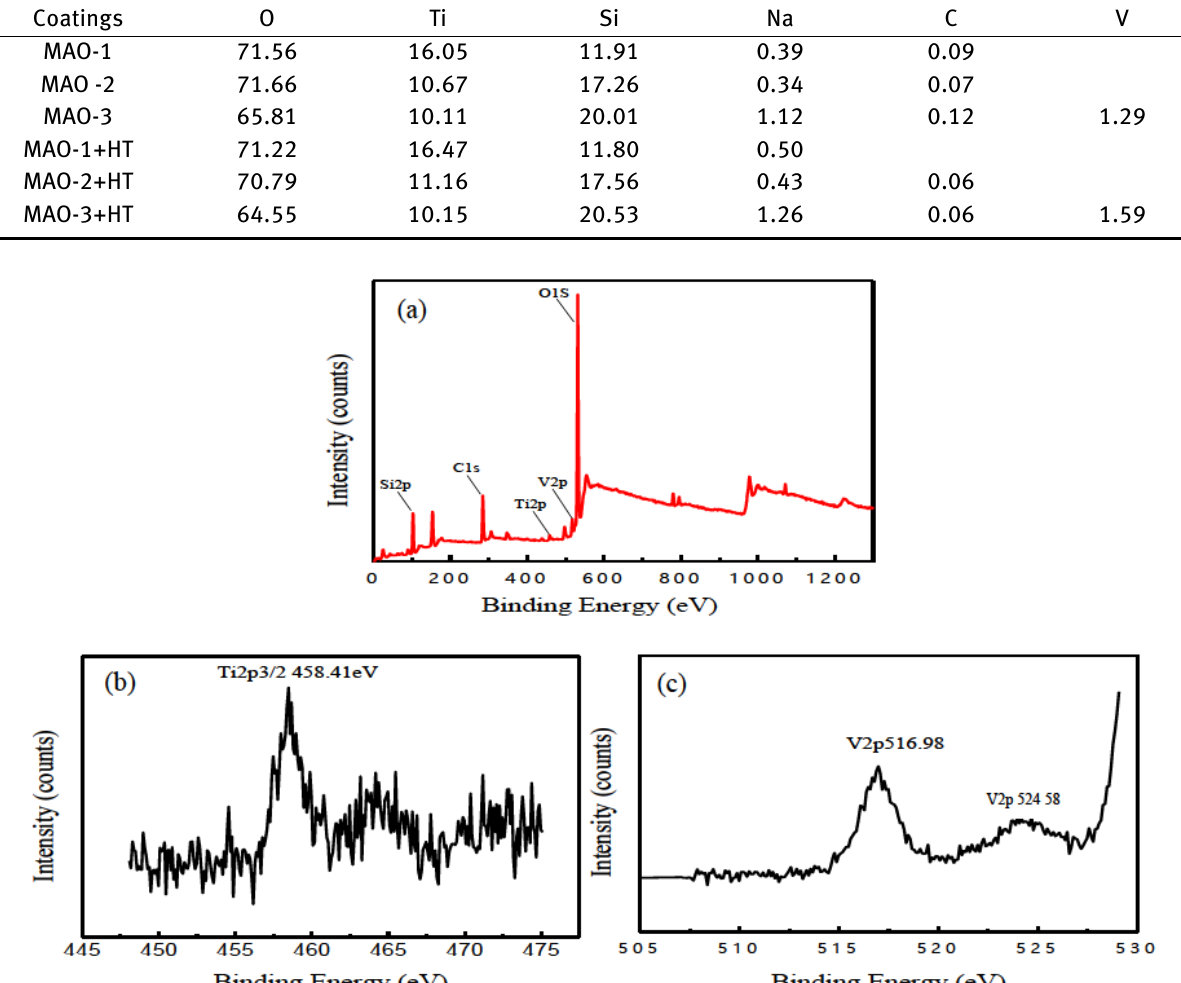
Figure 2: (a) XPS survey spectra, (b) typical Ti2p 3/2 and (c) V2p high-resolution XPS spectrum of MAO coating doped with V on Ti substrate after heat treatment